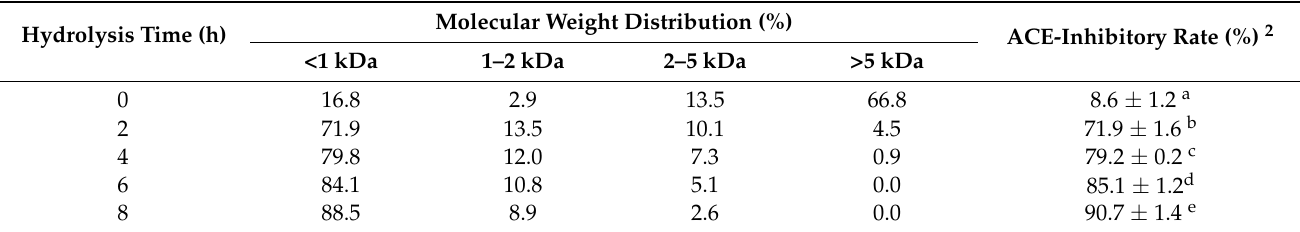
diagram (Figure 5). After the four-step process, 624.7 g peptides powder was obtained with a product yield of 62.5%. Table 3. Molecular Weight Distribution and ACE-Inhibitory Activity of the Duck Hemoglobin and Hydrolysates 1 . Hydrolysis Time (h)